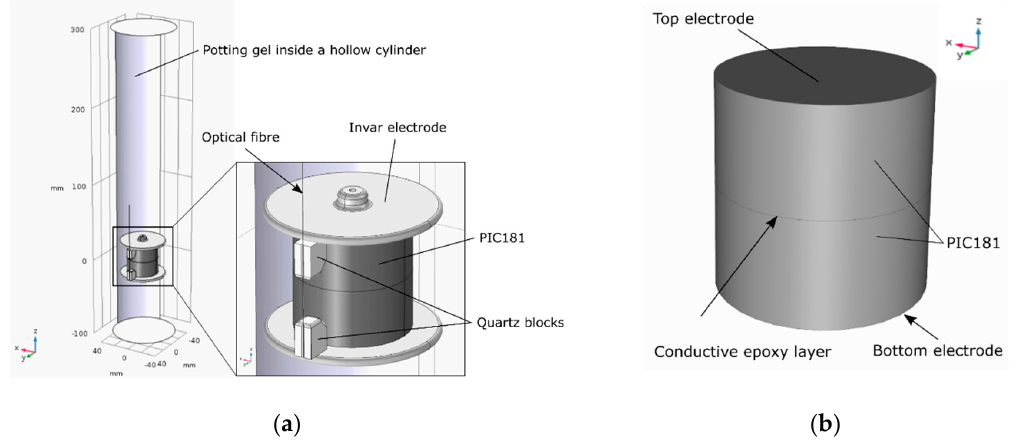
Figure 10. MV PVT inner components: ( a ) general view; and ( b ) simplified transducer geometry implemented in COMSOL Multiphysics®.